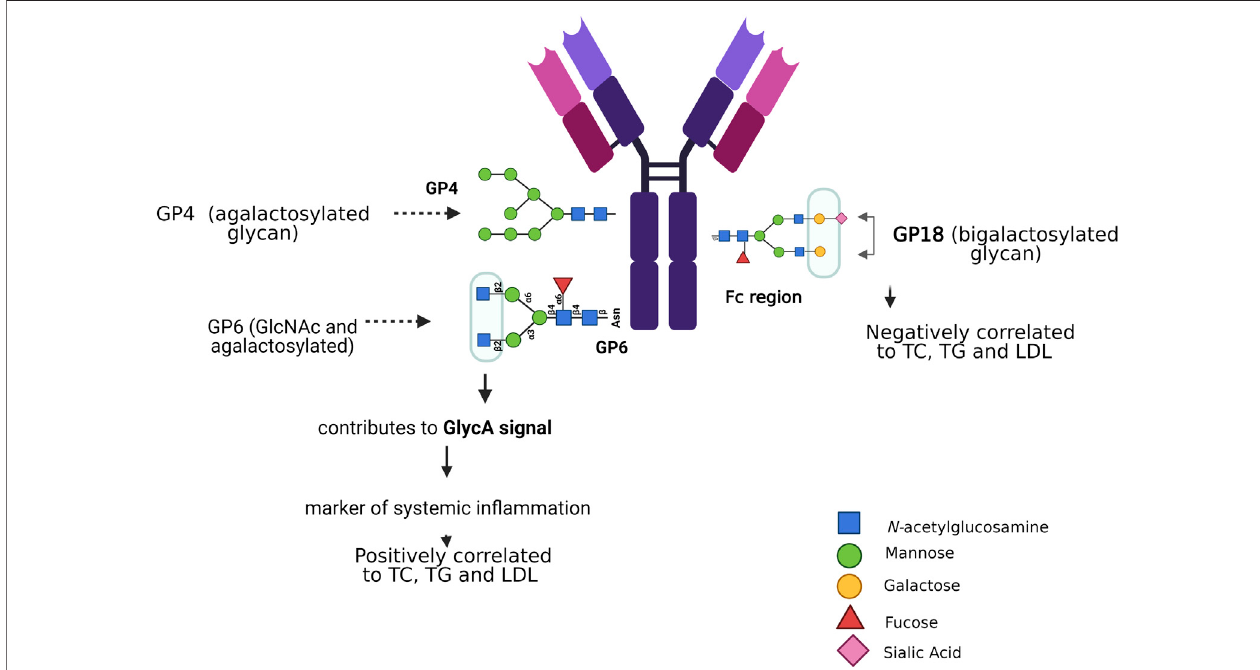
FIGURE 4 | N- glycosylation associated with risk factors for dyslipidemia. N- glycans that attach to the Fc portion of IgG modulate the effector functions of IgG. Agalactosylated glycans and bisecting GlcNAc are positively correlated with elevated lipid levels, unlike sialylated and bigalactosylated glycans that are negatively correlated with TC, TG, and LDL. Characterizing the serum glycome could be a novel tool to identify markers and potential mediators of